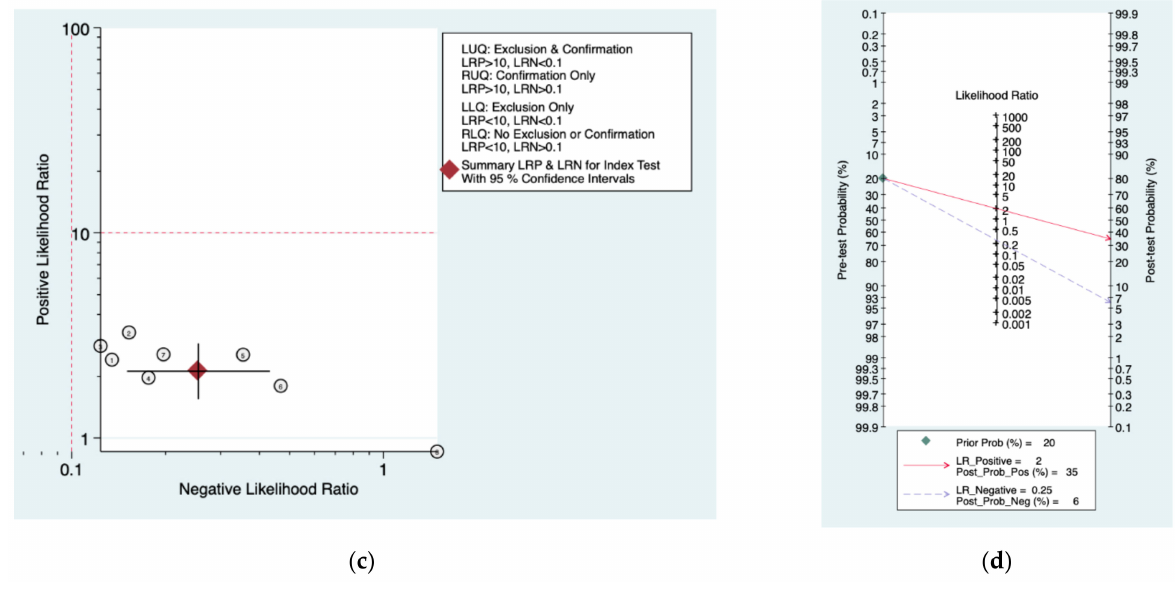
Figure 11. Meta‑analysis of AAO protocol. ( a ) Forrest plot of pooled sensitivity and